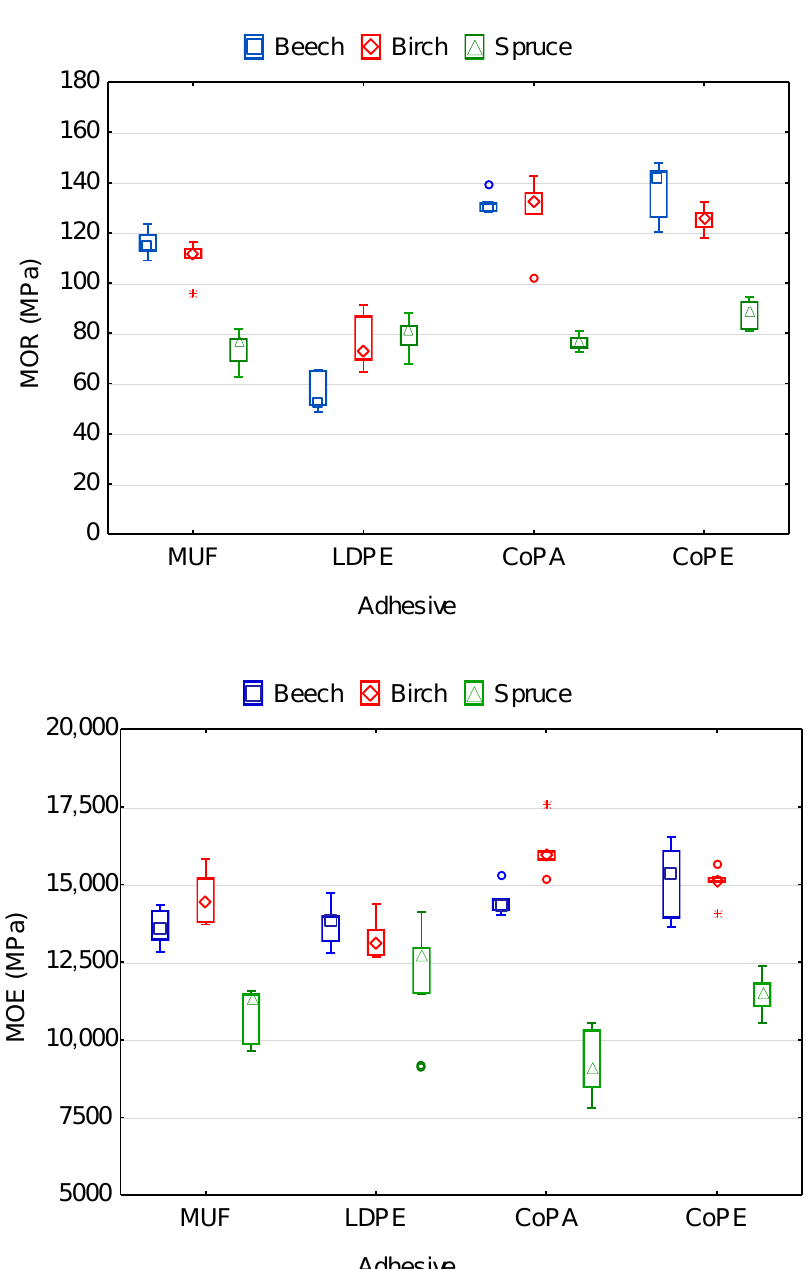
Figure 2. Bending strength and modulus of elasticity in bending of plywood panels bonded with di ff erent types of adhesive and using various wood species.